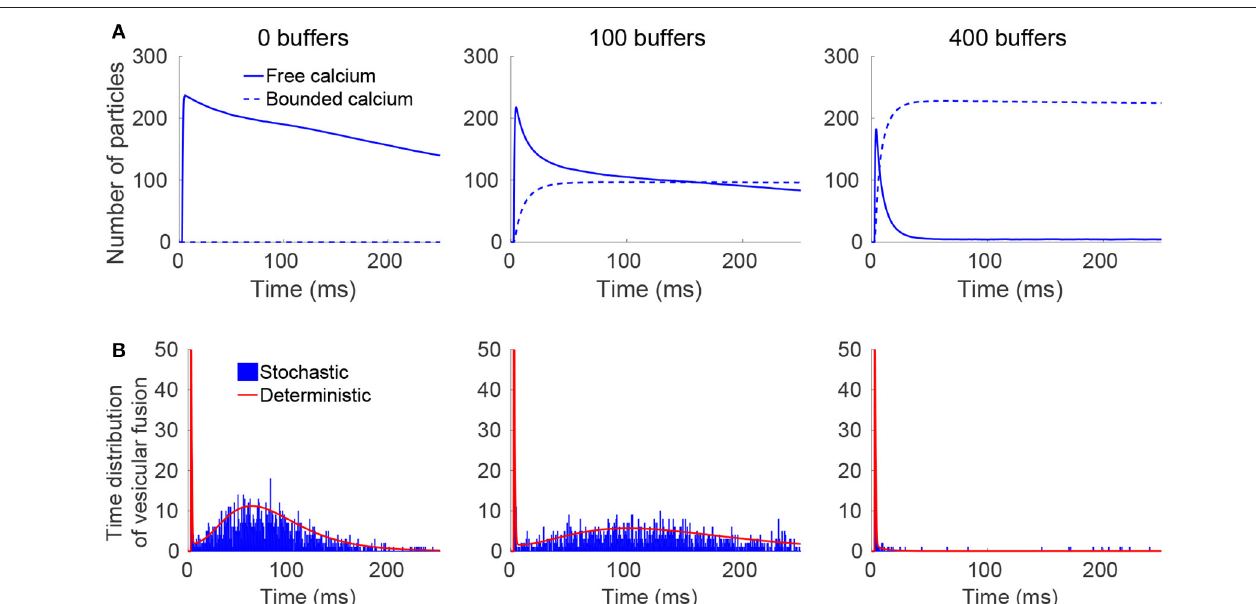
FIGURE 2 | Consequences on the release probability of calcium channel location and vesicular crowding at the AZ. Calcium time course in the pre-synaptic terminal and vesicular release activation. (A) Number of free (continuous) and buffered (dotted) ions for 0 (left), 100 (middle), and 400 (right) buffer sites. (B) Histogram of vesicular release time for the stochastic (blue), and the Markov-mass action model (red) for 0 (left), 100 (middle), and 400 (right) buffer